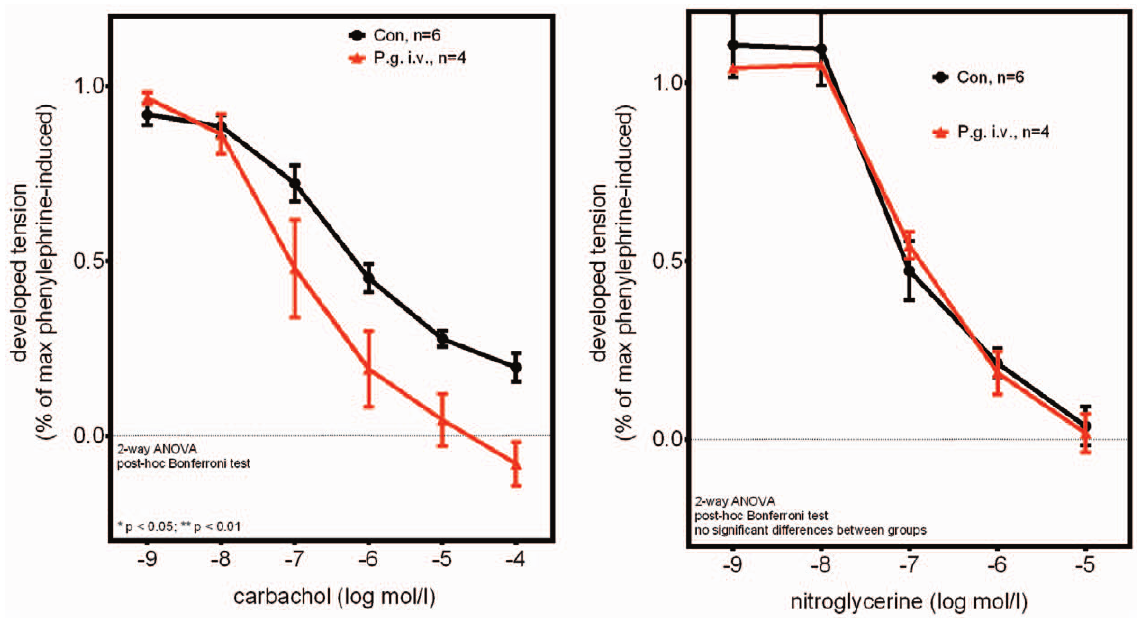
Figure 4. Improved endothelium-dependent vasodilation in P. gingivalis infected mice (left panel). No difference between groups in endothelium-independent vasodilation (right panel). Data are presented as means of 3–4 aortic ring preparations/mouse 6 SEM. Statistical testing was performed using 2-way ANOVA and post-hoc Bonferroni tests.